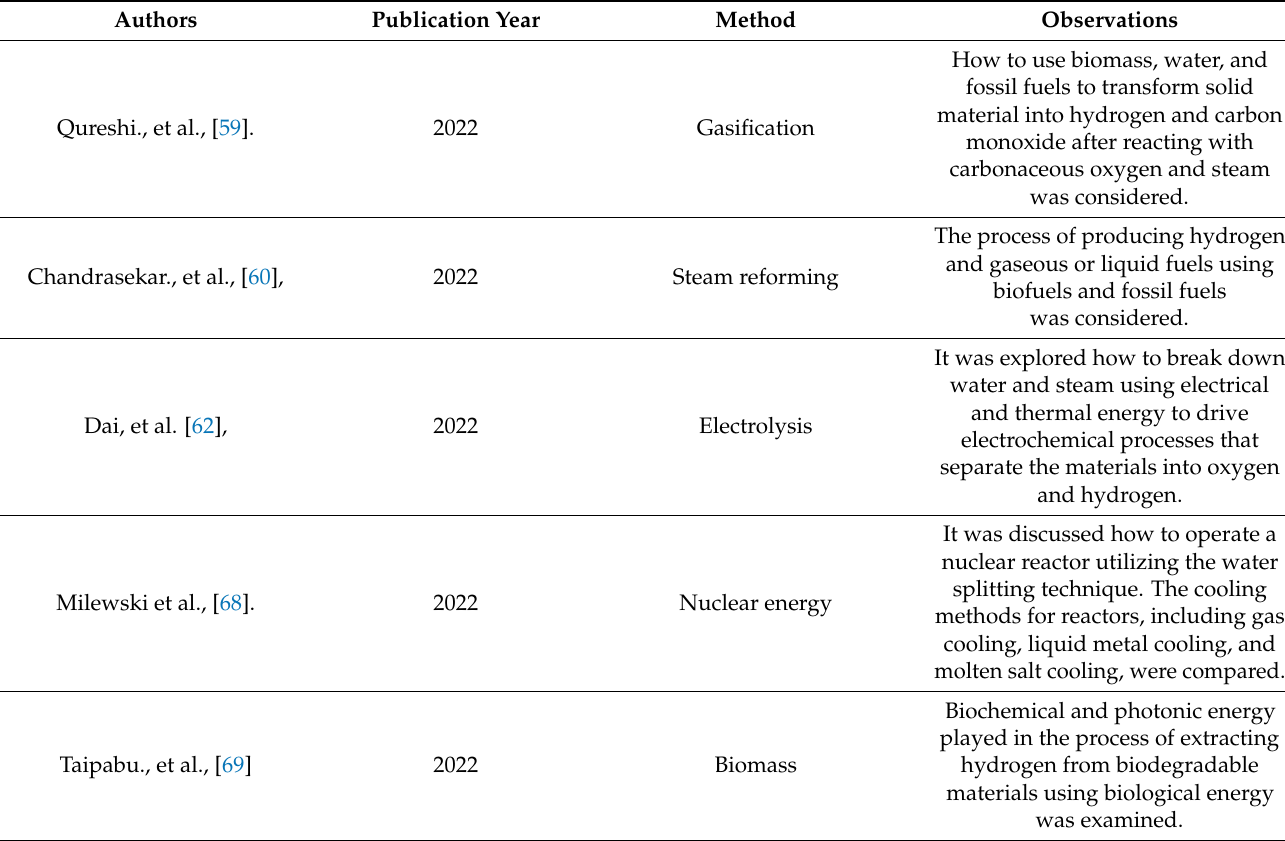
Table 1. Comparison of various hydrogen production